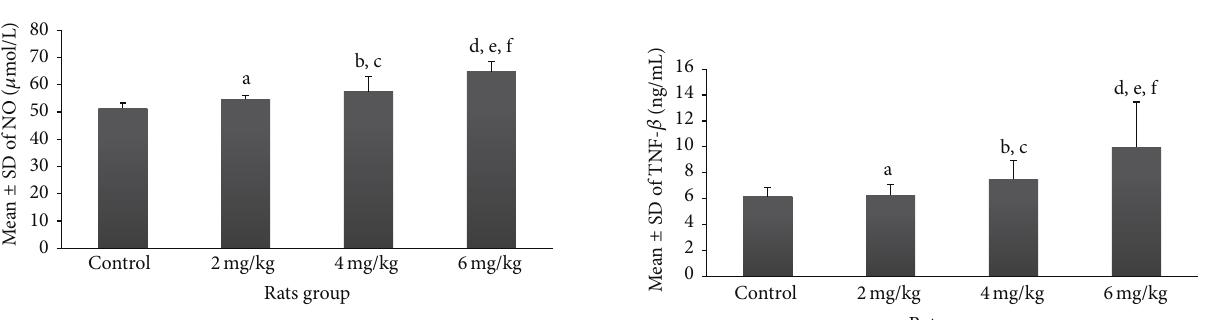
Figure 2: Prenatal exposure to nicotine in pregnant rats increased inflammatory marker of IL-6 in newborn rats. Mean ± SD of the IL- 6 marker is shown in different groups of newborn rats. 𝑁 = 8 (a: 𝑃 > 0.05 in 2 mg/kg group versus control group; b and c: 𝑃 < 0.001 and 𝑃 > 0.05 in 4 mg/kg group versus control group and 2mg/kg group, resp.; d, e, and f: 𝑃 < 0.0001 , 𝑃 < 0.001 , and 𝑃 < 0.001 in 6 mg/kg group compared to control, 2mg/kg, and 4mg/kg groups, resp.).